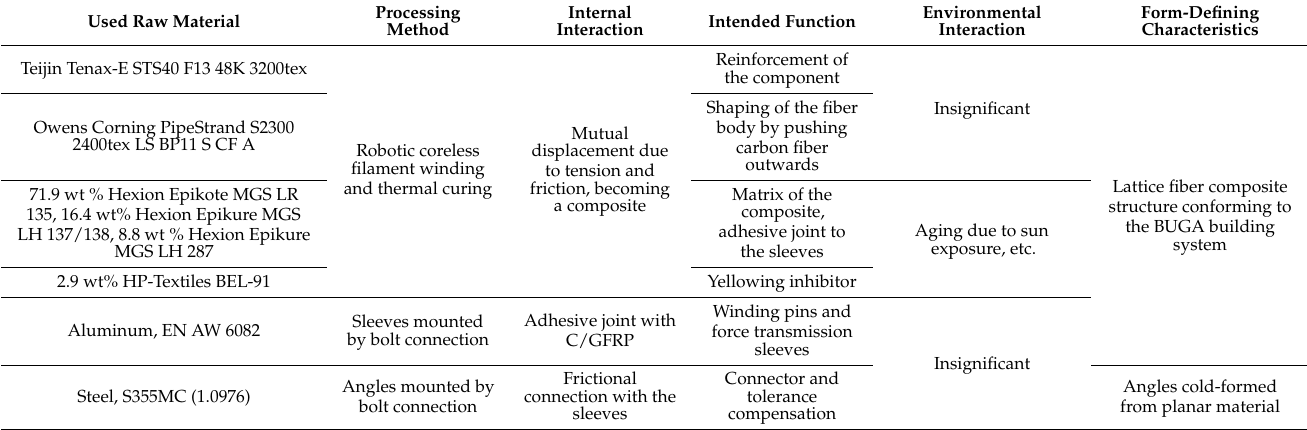
Table 1. Overview of the material system used for the fabrication of the BUGA component. Used Raw